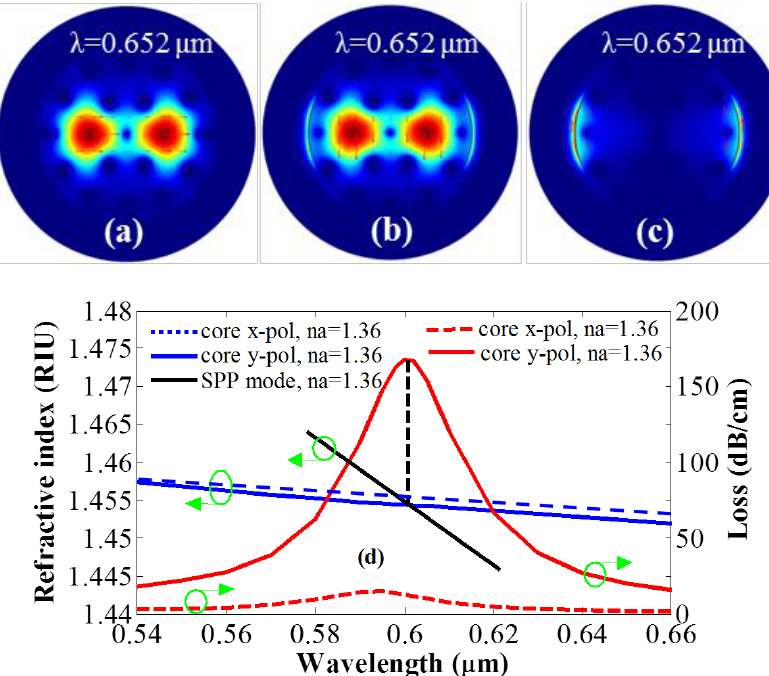
Figure 2. Mode field distribution of fundamental ( a ) x -polarization core mode, ( b ) y -polarization core mode, and ( c ) y -polarization SPP mode at 0.652 µm. ( d ) Dispersion relation between the fundamental core-guided mode and SPP mode with n a = 1.36 and t g = 30 nm.